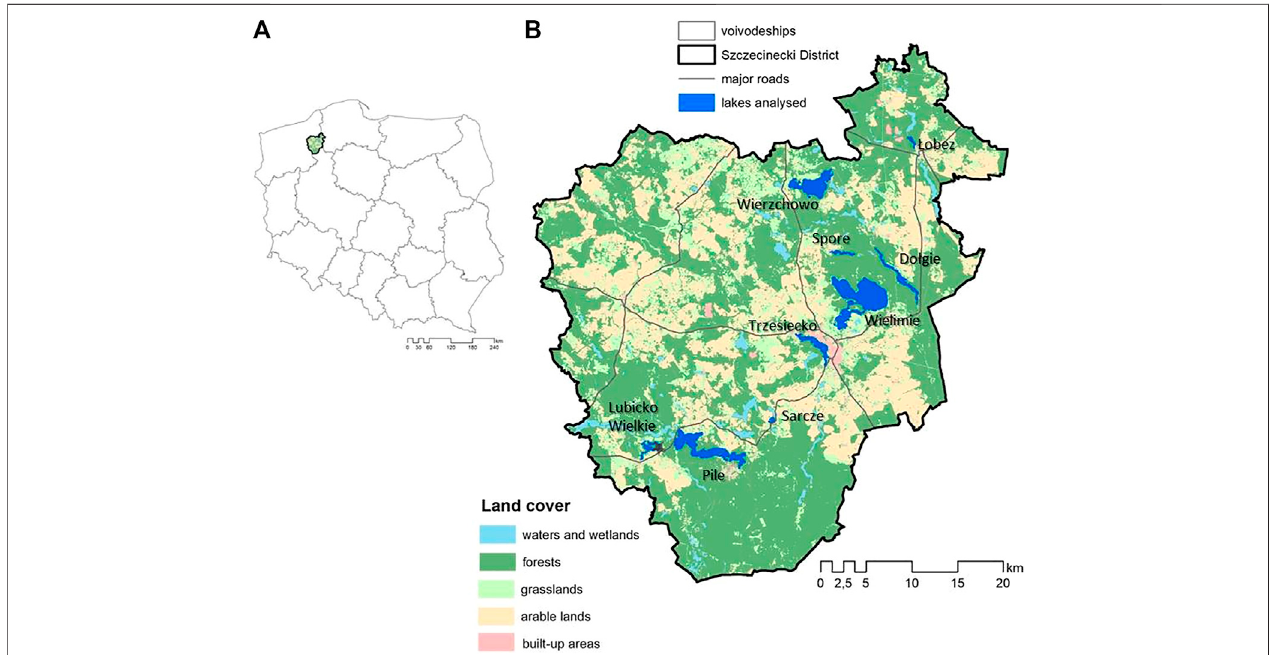
FIGURE 1 | Location of study area: (A) within Poland, (B) within the Szczecinecki District.